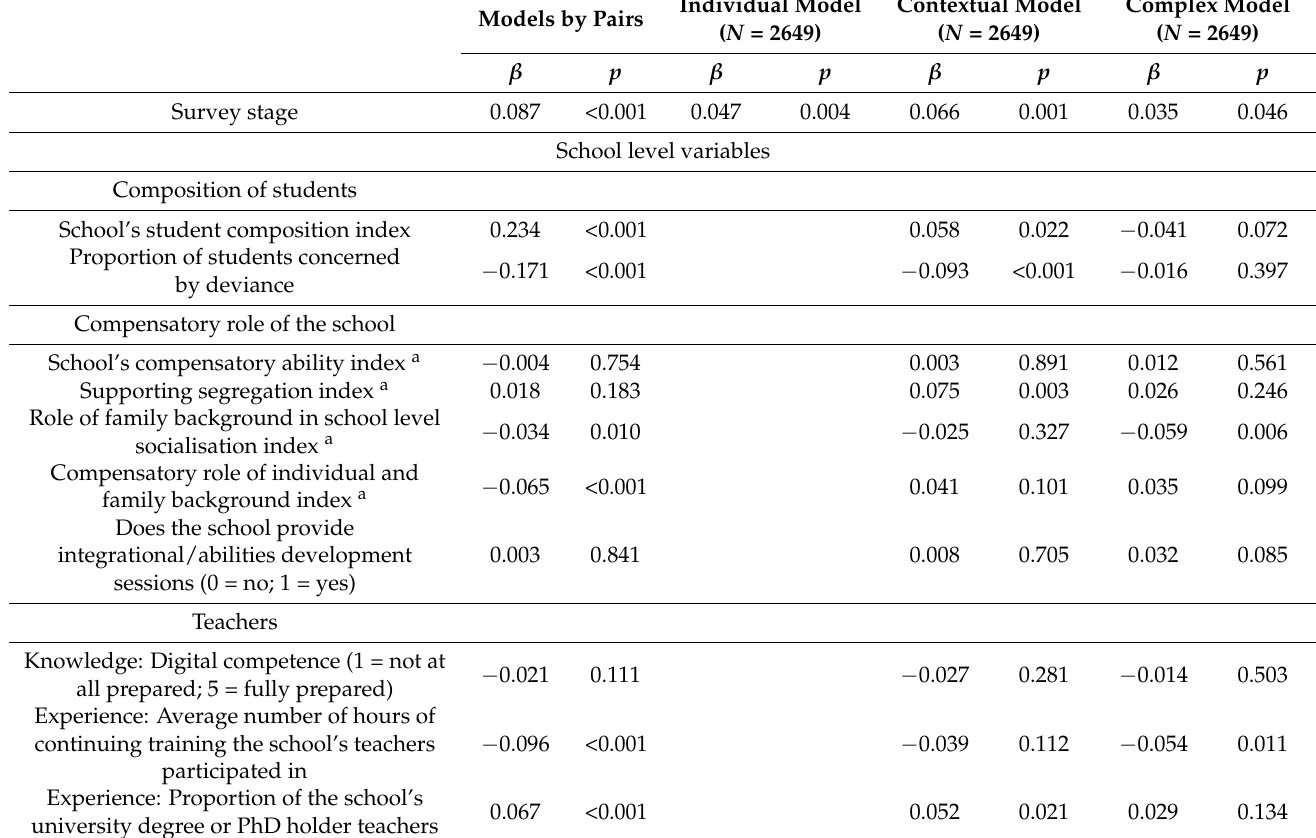
Table 3. Prediction of individual-level risk of dropping out through individual and school factors in two steps, in pairs and complex linear regression models constructed with multiple variable entry. Models by